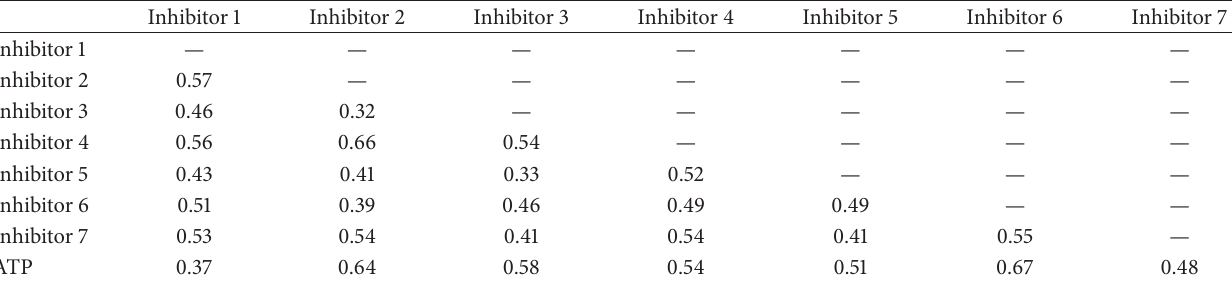
Table 4: RMSD values of ATP and the seven kinase inhibitors amongst each other.